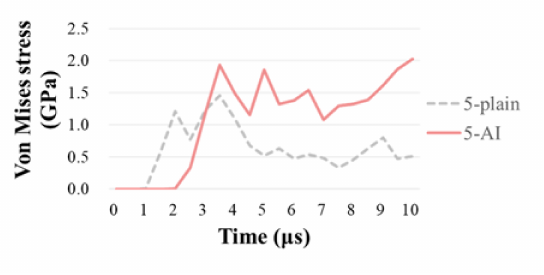
Figure 14. Stress response of node C 3d and C 2d in 5-AI and